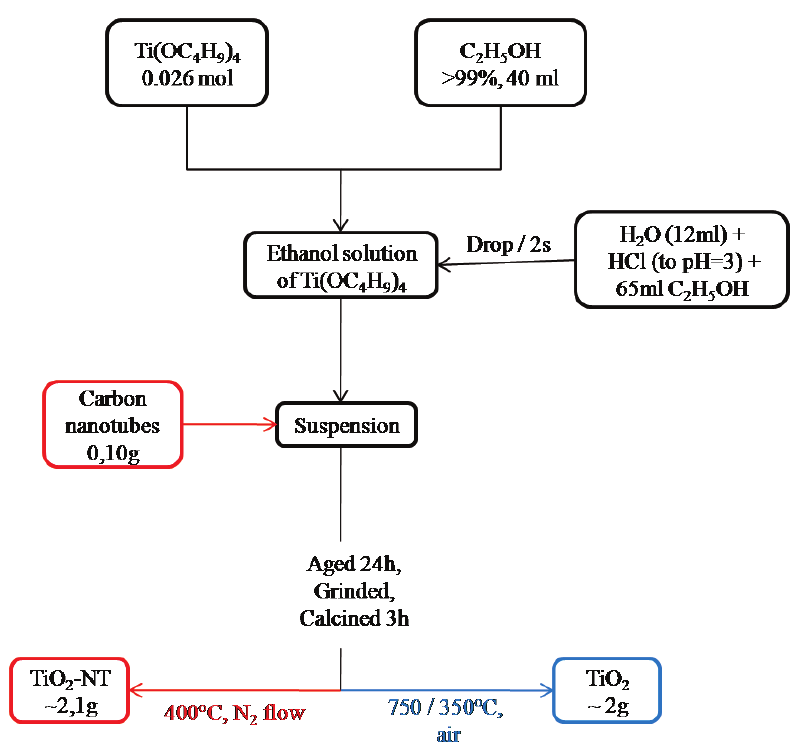
Figure 2. Scheme of the preparation of TiO